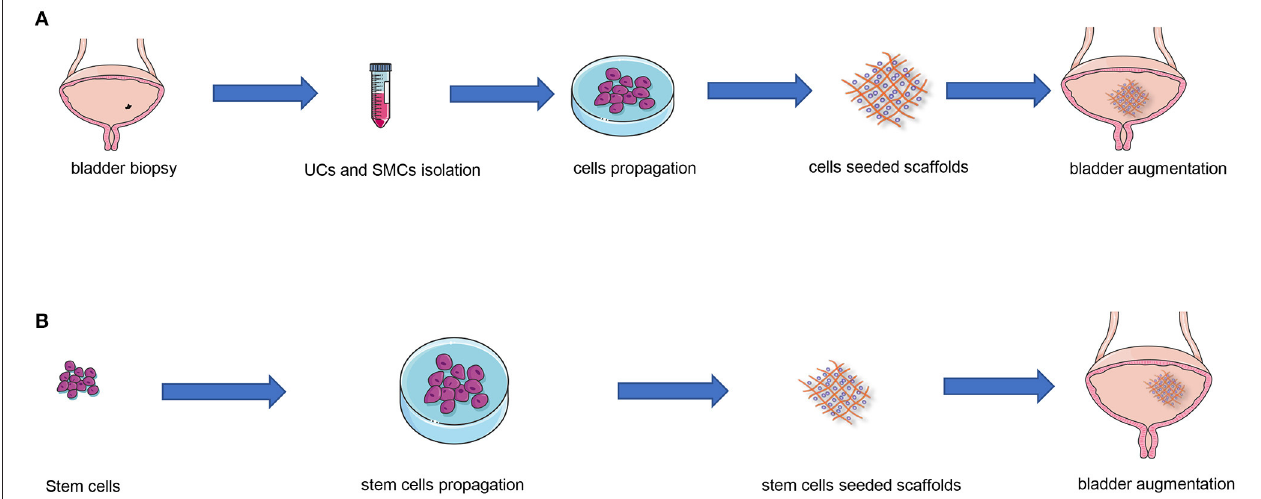
FIGURE 2 | Tissue engineering strategies for autologous urothelial cells and stem cells. (A) UCs and SMCs obtained from the biopsy material first proliferate in the cell culture incubator; then the proliferated cells are subsequently reseeded into a tissue-engineered scaffold; eventually, the scaffold with cells was reimplanted into the same host. (B) Firstly, stem cells proliferate in the cell culture incubator; subsequently, the proliferated cells are seeded into a tissue-engineered scaffold; eventually, the scaffold with cells was implanted into the host. UCs, urothelial cells; SMCs, smooth muscle